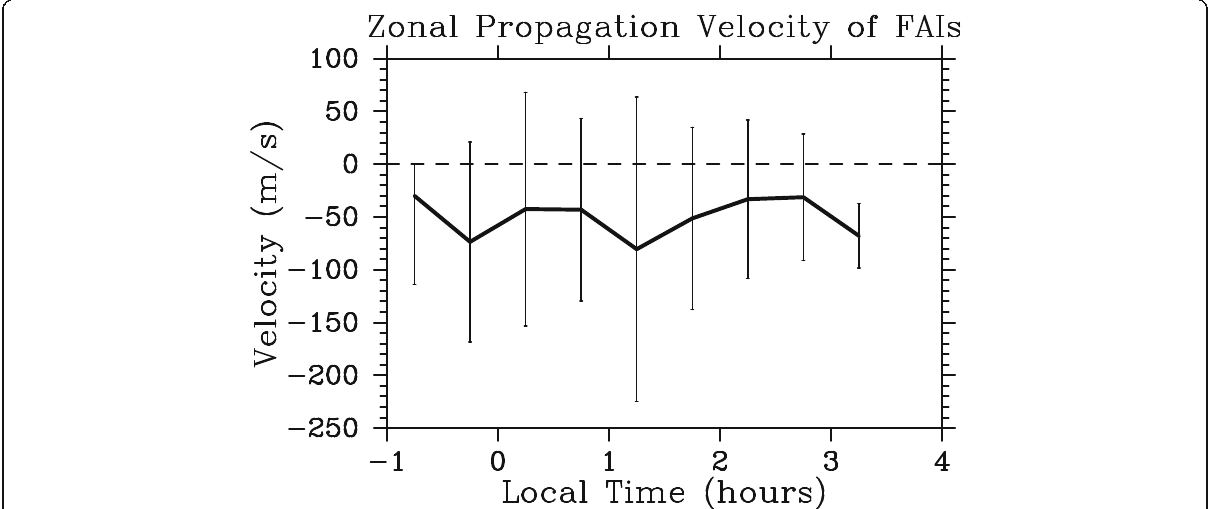
Fig. 5 Local time variation of averaged zonal propagation velocity (after Otsuka et al.